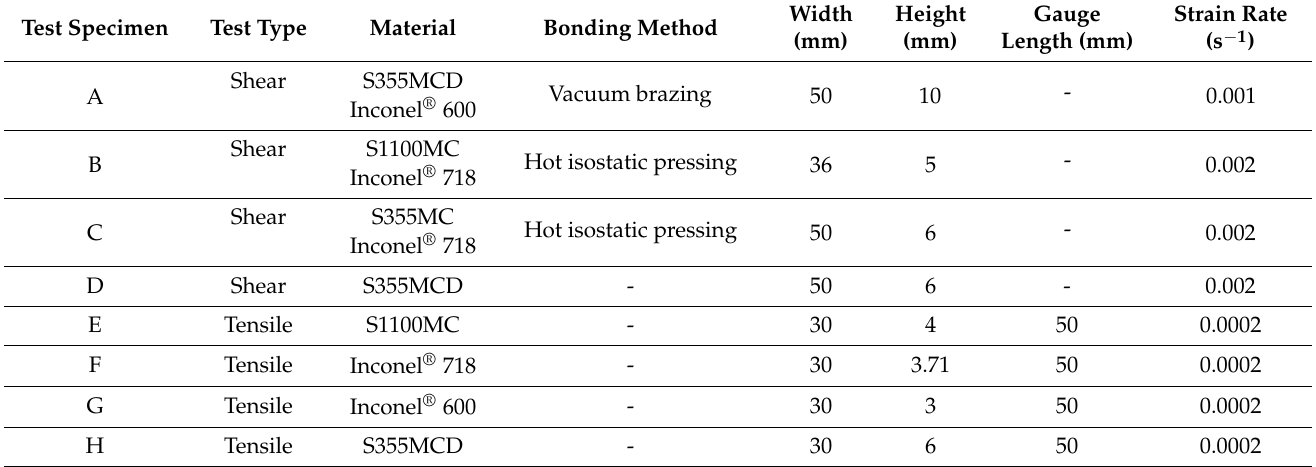
Table 3. Test and test specimen